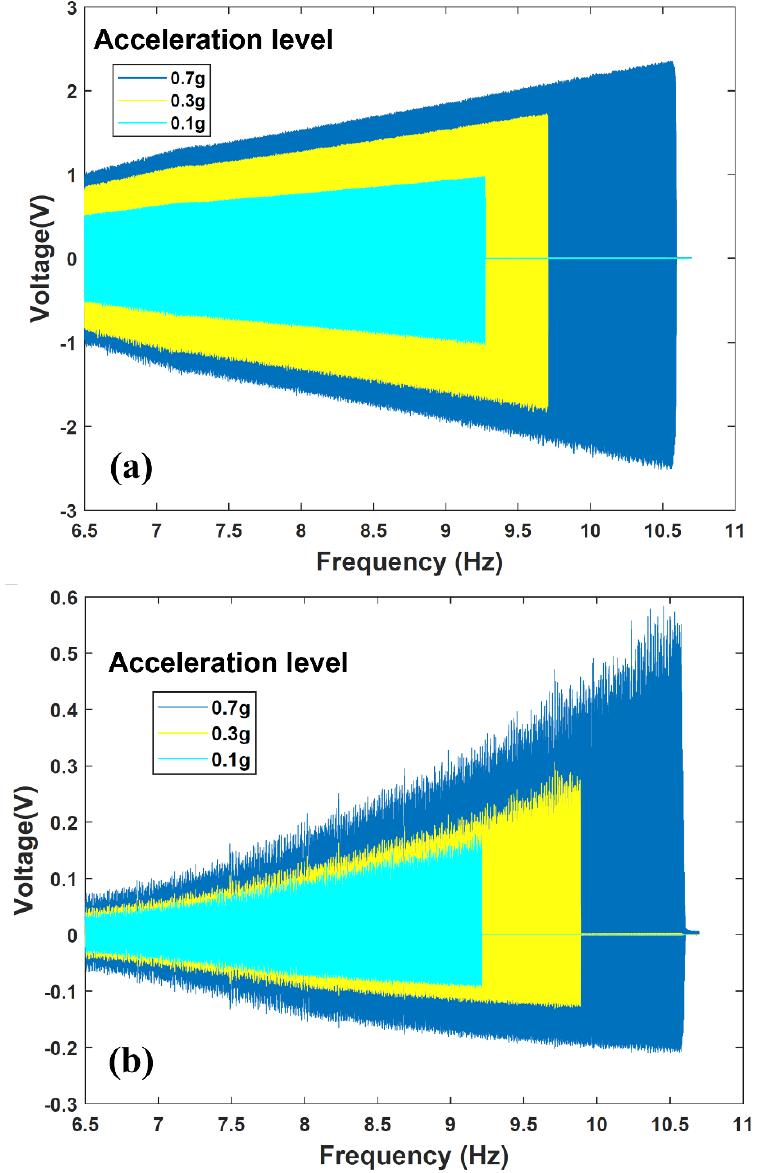
Figure 14. Energy harvester-sensor unit closed circuit frequency response at a range of input accelerations. ( a ) Energy harvester closed circuit voltage values measured across the microcontroller subsystem. ( b ) FR4 sensor diaphragm closed circuit voltage values measured across the input to the microcontroller.